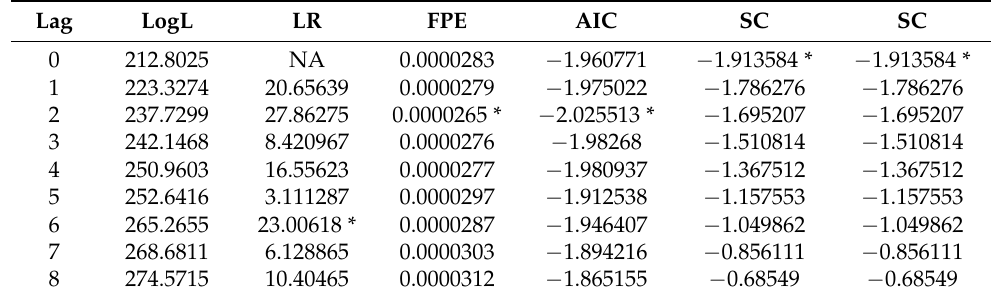
Table 5. Length criteria: ECO, FSI, and